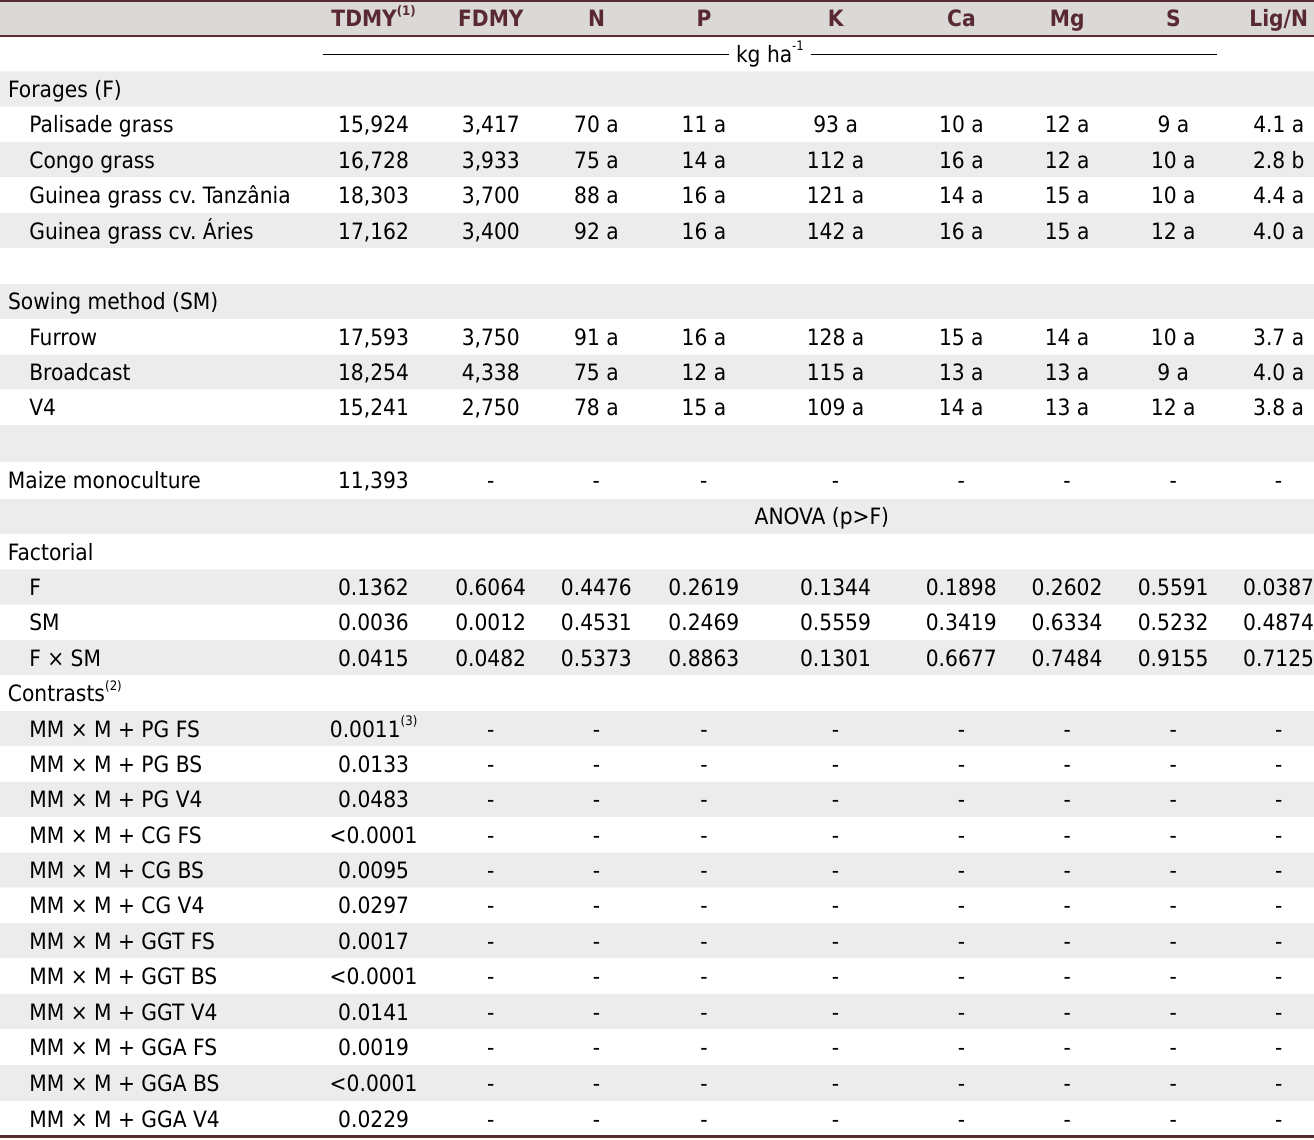
ANOVA in factorial and contrasts